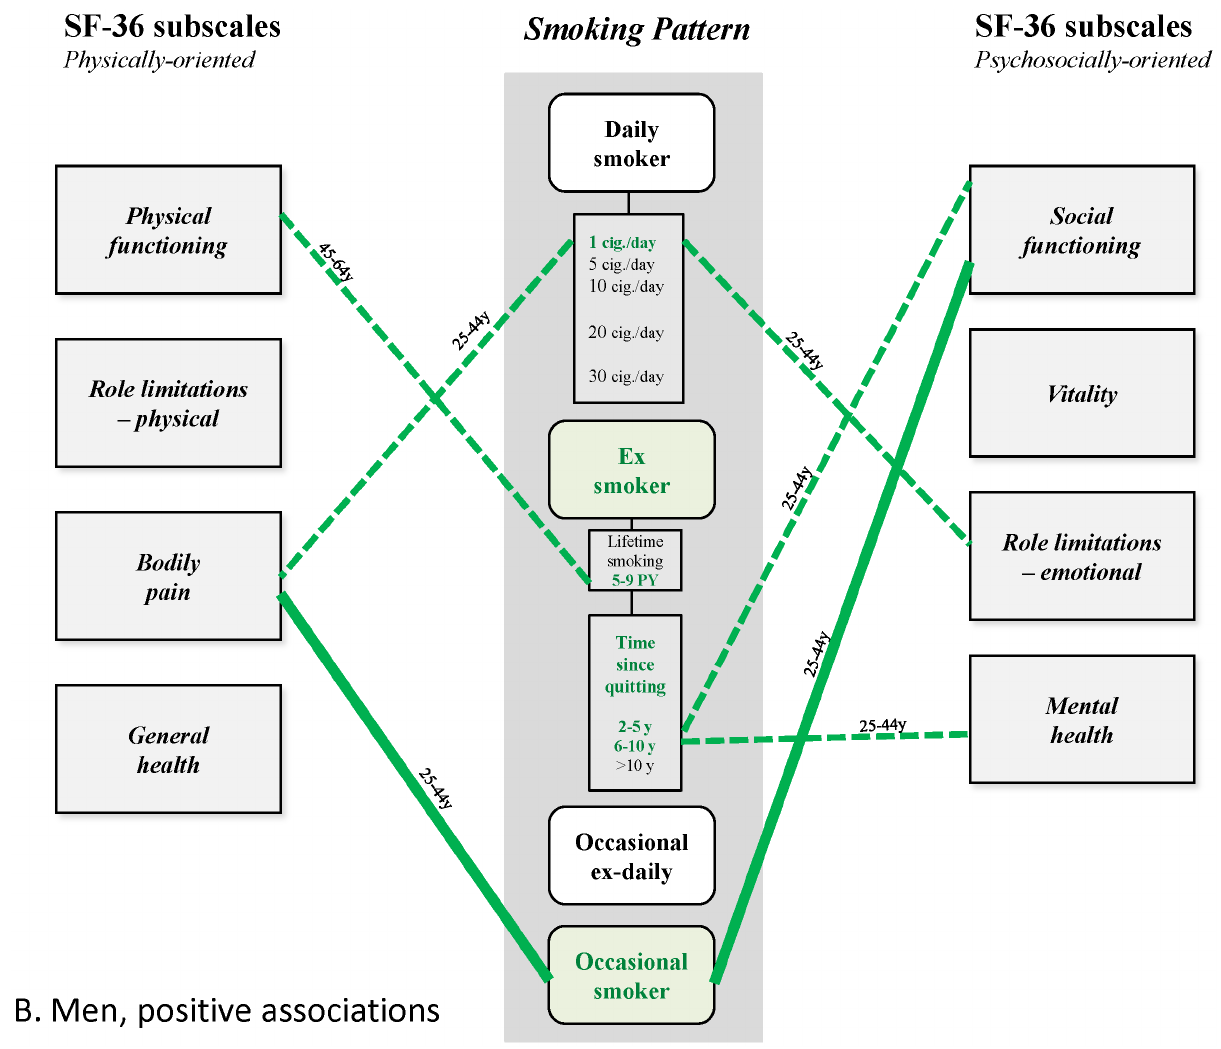
Figure 5. Patterns of relationships found in this study. Men, negative associations.